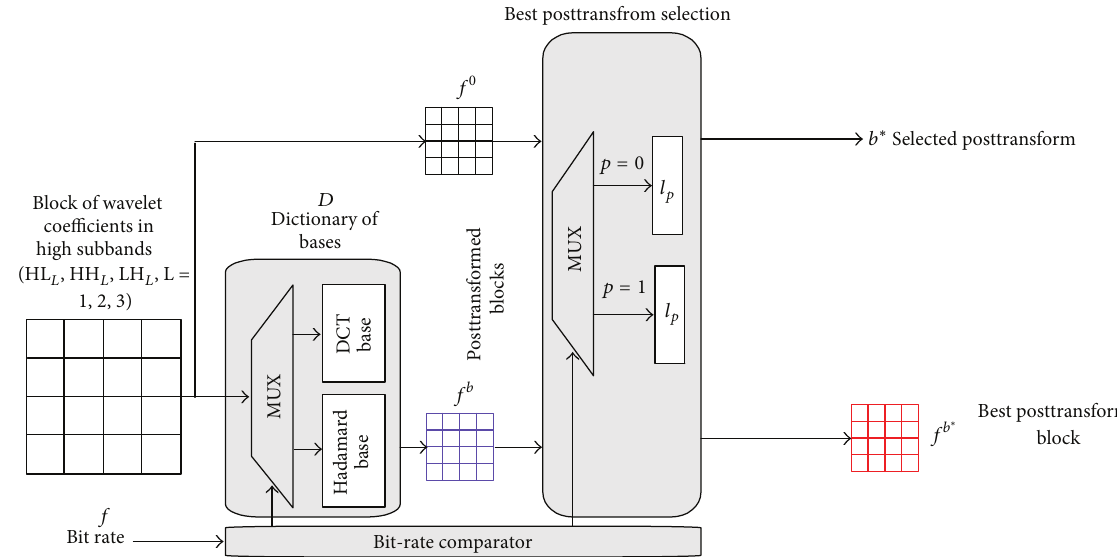
Figure 6: The proposed posttransform